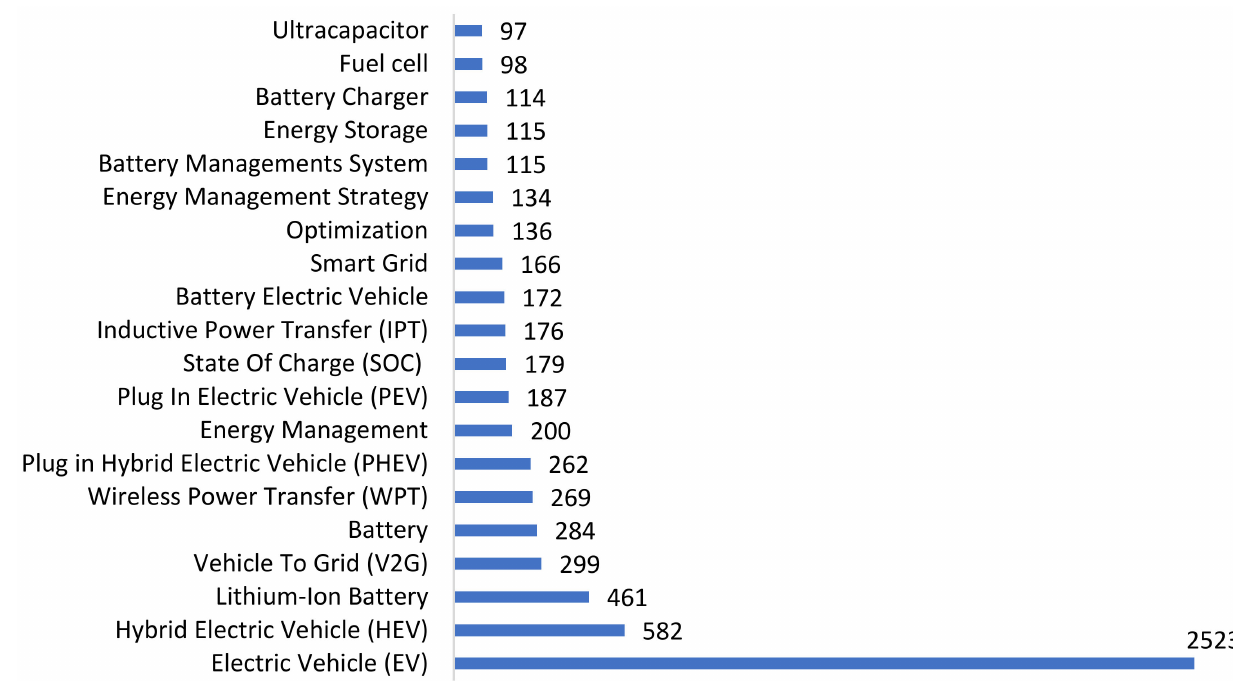
Figure 5. Representation of the 20 most repeated